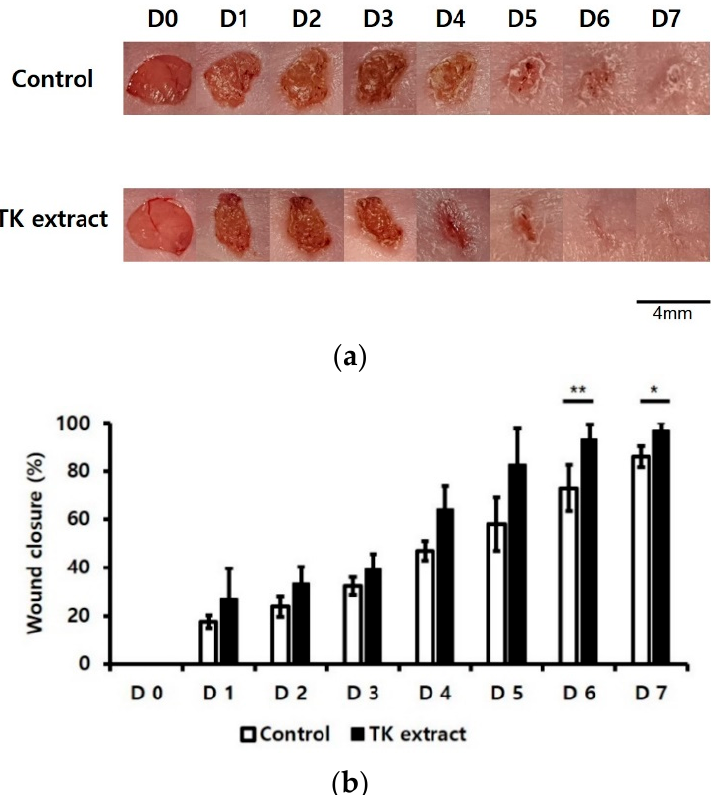
Figure 7. TK extract promoted in vivo wound healing. In vivo wound-healing activity was measured using BALB/c mice. The 4 mm-diameter wounds were created by both backsides of 6~7-week-old BALB/c mice. ( a ) The results were imaged to show wound healing. ( b ) The wound closure (%) graph of ( a ). (*: p < 0.05, **: p < 0.01.)